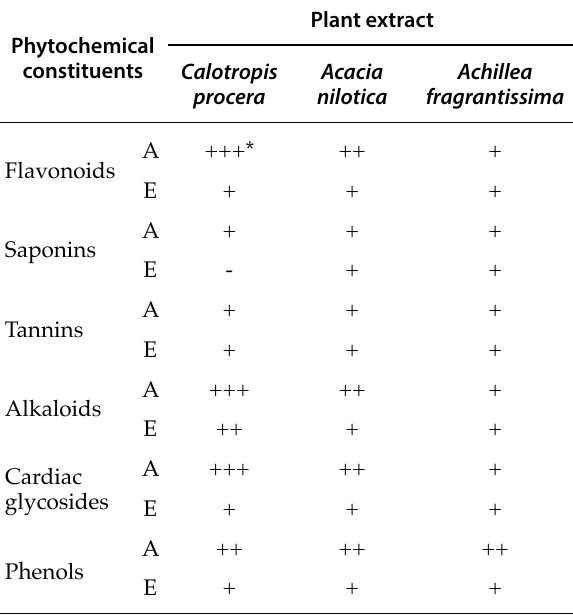
Table 3. Qualitative analysis of phytochemical constituents of aqueous (A) or ethanol (E) extracts from leaves of three medicinal